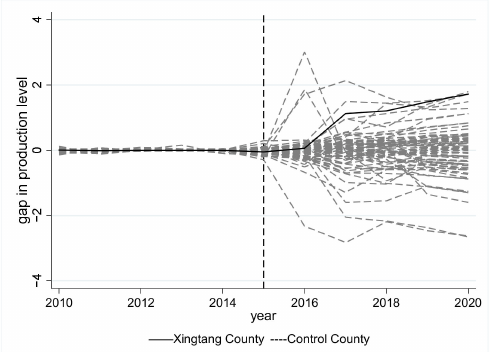
Figure 10. Cattle industry production level gaps in Xingtang County and all Control